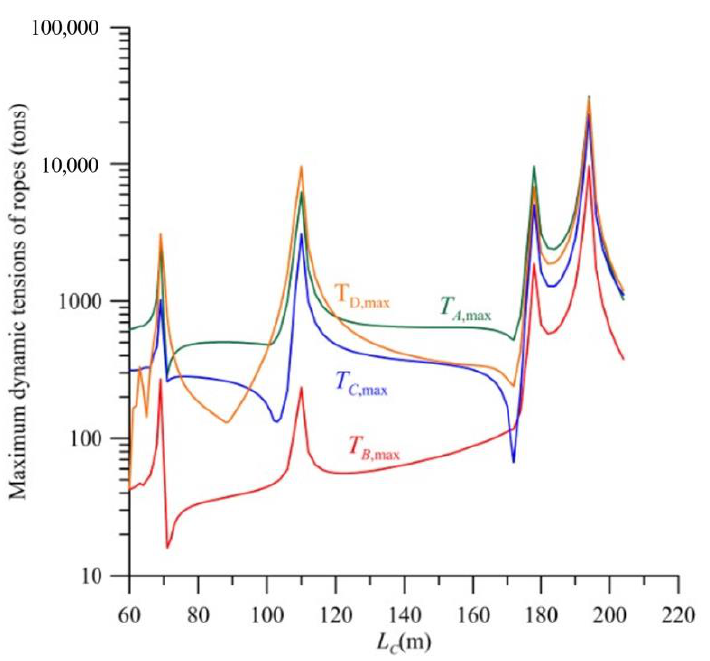
Figure 7. Dynamic tension of the four ropes under the typhoon irregular wave as a function of the diving length L C and the mass of pontoons M 3 and M 4 .